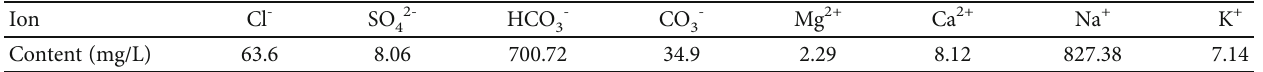
Table 2: The ion composition of simulated formation